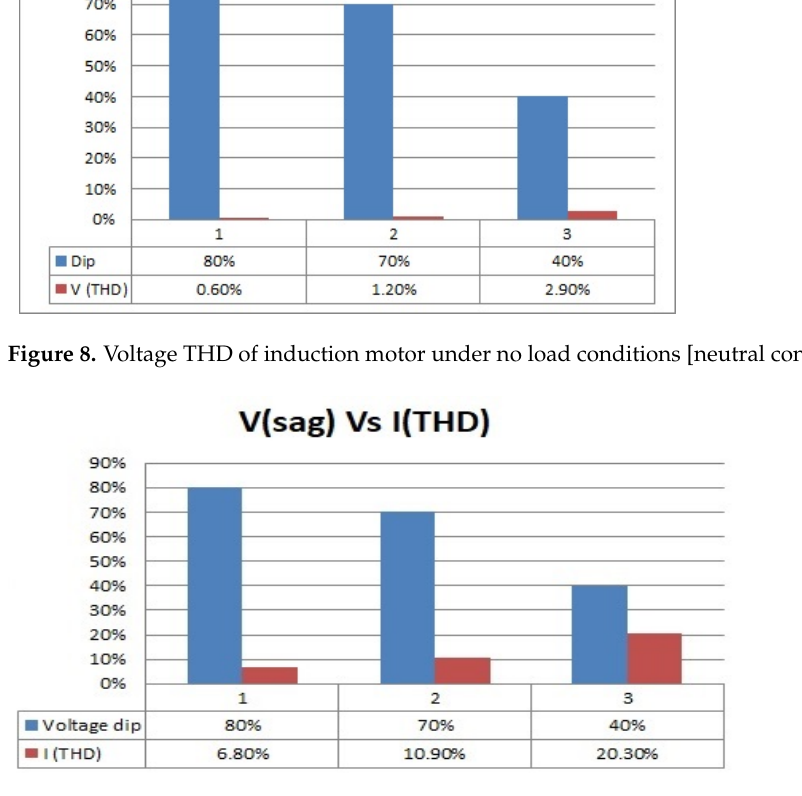
Figure 9. Current THD of induction motor under loaded conditions [neutral connected].